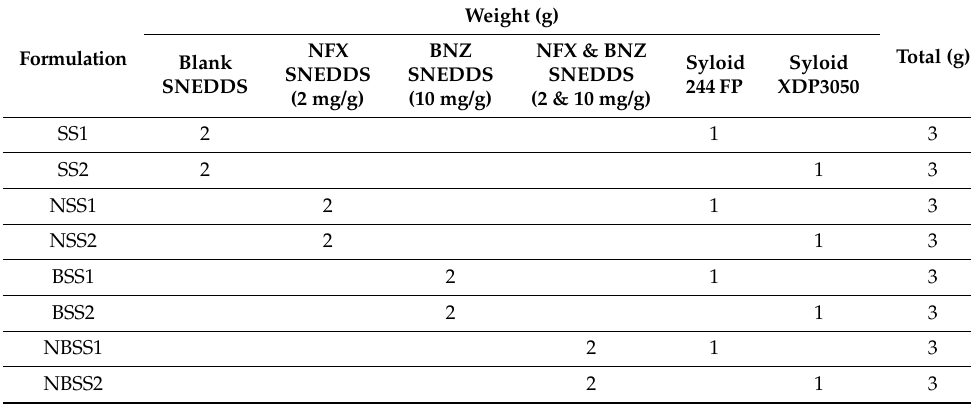
Table 2. Solid SNEDDS formulations